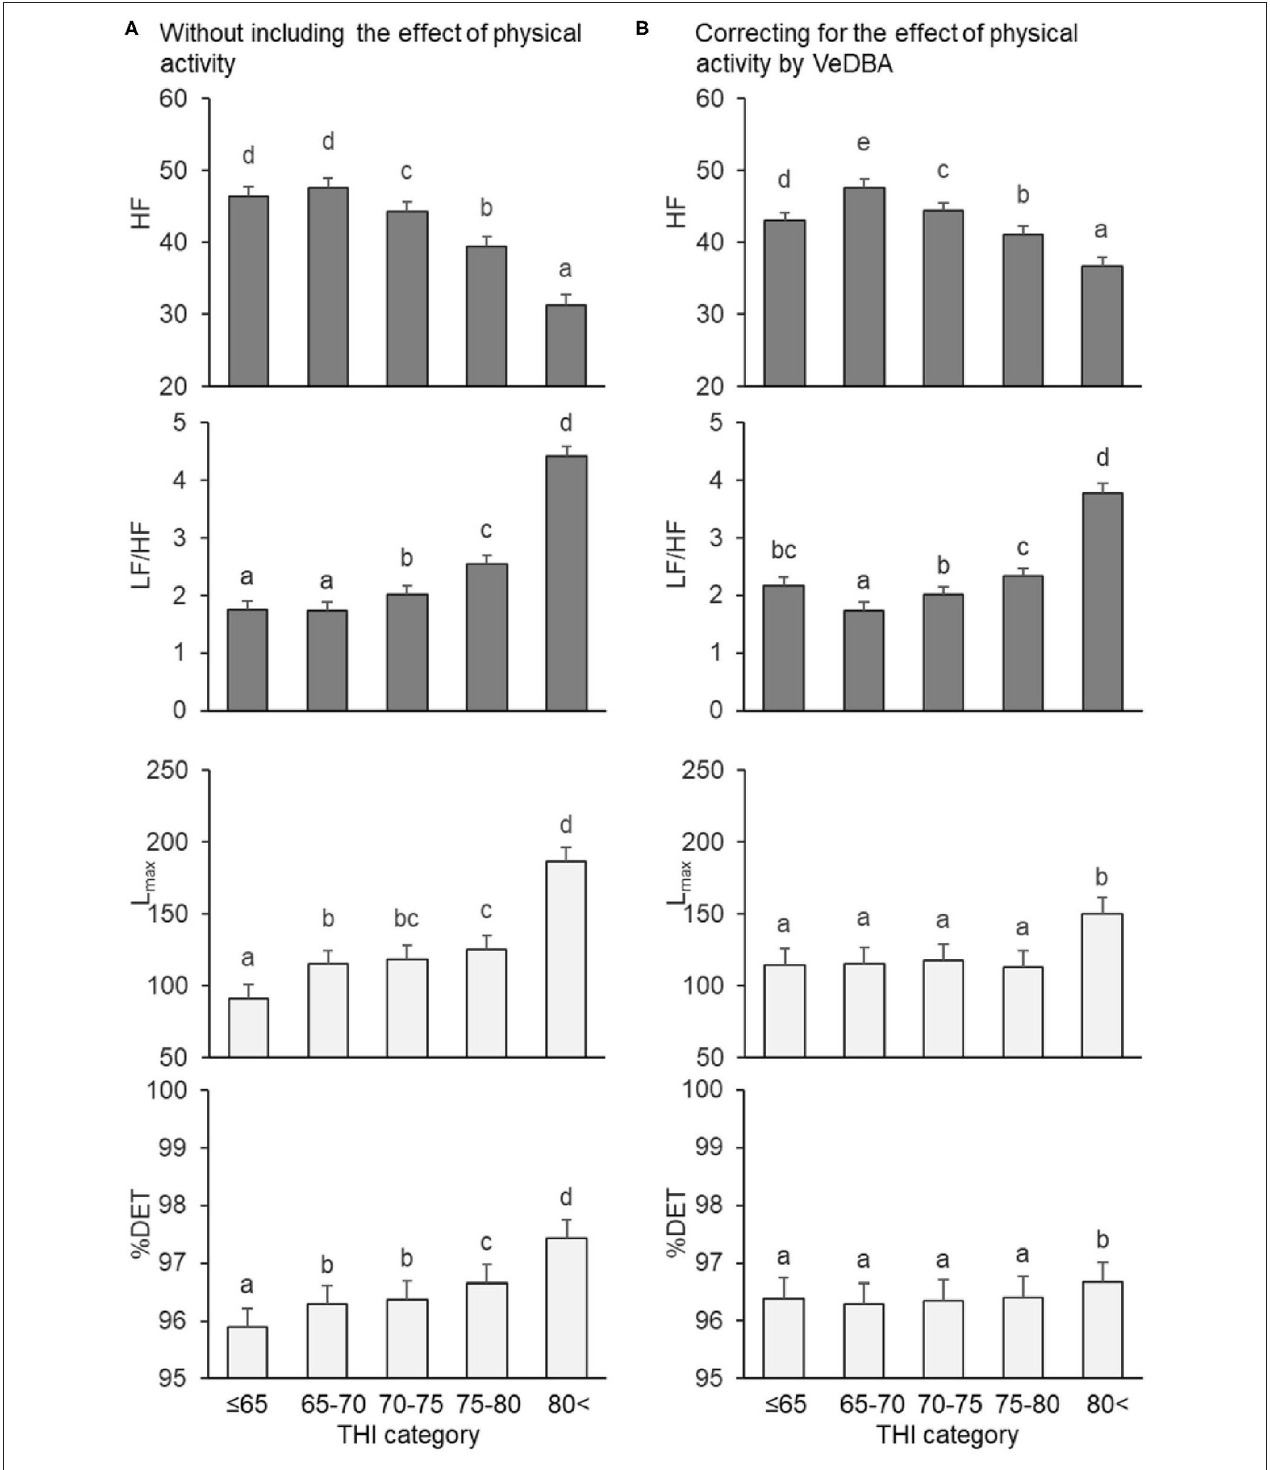
FIGURE 3 | Changes in frequency and non-linear domain parameters by THI category, (A) without and (B) with the effect of physical activity quantified by VeDBA. HF and LF/HF are frequency domain parameters (gray bars), and L max and %DET are non-linear parameters (white bars). The bars represent least square means, and error bars show standard errors. Values with different letters differ significantly ( P < 0.05). HRV, heart rate variability; HF, normalized power of the high-frequency band (n.u.); LF/HF, ratio of the normalized power of the low-frequency (LF) band to HF; L max , the length of the longest line of recurrent points (beats); %DET, percentage of recurrent points that appear in sequence (%); THI, temperature–humidity index; VeDBA, natural logarithmically transformed vectorial dynamic body acceleration (g).